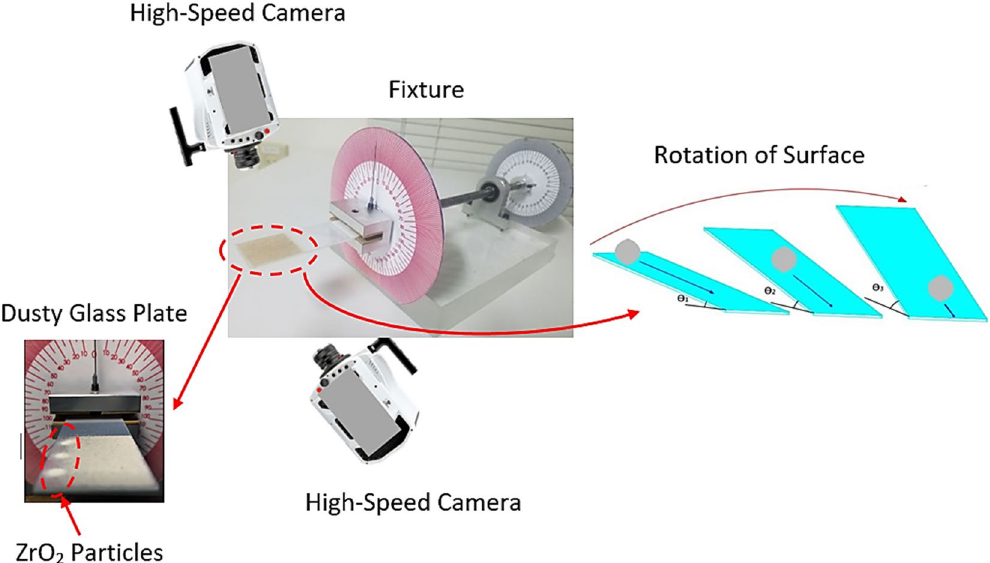
Figure 1. Schematic image of experimental